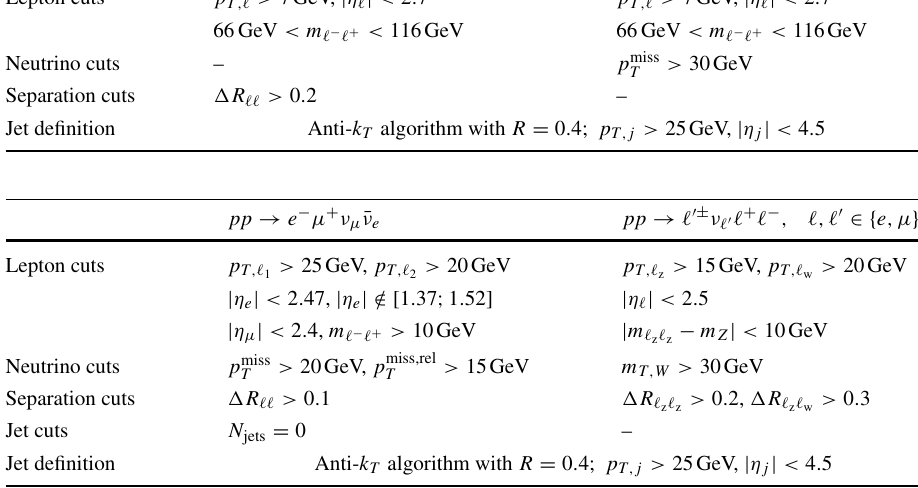
Table 9 Default setup of fiducial cuts for Z Z and Z Z / W + W − production processes